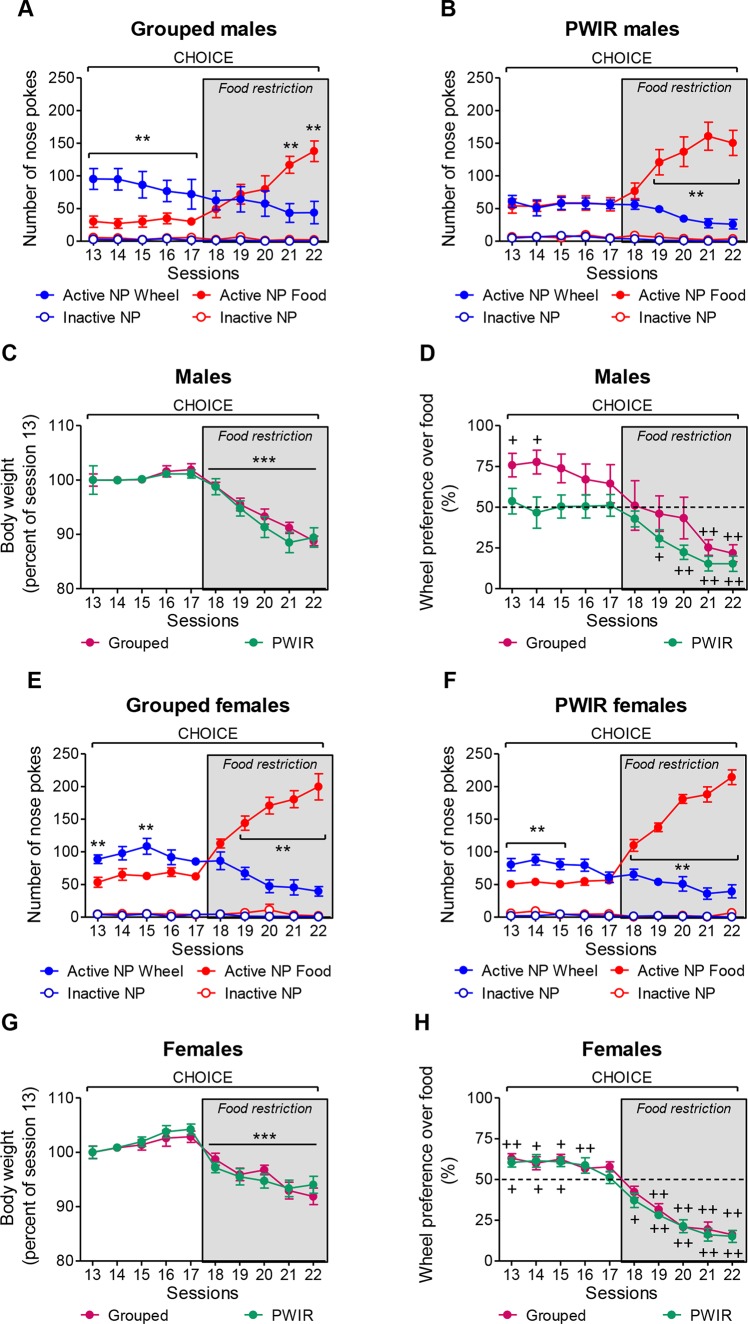
Sex-dependent effects of post-weaning isolation rearing (PWIR) on the preference between running and palatable feeding (choice sessions). (A) The difference in nose poke responses for running over feeding in grouped males was progressively inversed with food restriction. (B) Fed PWIR males displayed equal numbers of nose responses for running and feeding. (C) Grouped and PWIR male mice showed similar body weight losses during food restriction. (D) Grouped, but not PWIR, mice displayed time-dependent preferences for wheel-running over feeding. (E,F) The difference in nose poke responses for running over feeding in grouped and PWIR females was progressively inversed with food restriction. (G) Identical body weight losses in food-restricted grouped and PWIR female mice during the choice sessions. (H) Similar profiles of wheel-running preference over feeding in grouped and PWIR females during the choice sessions. The values are the mean ± standard error of the mean of n = 5–6 mice. ** p < 0.01 for the time-dependent differences between nose poke responses for wheel-running and feeding ( post hoc Tukey tests following significant session x reward interaction in the multiple-way analyses of variance), and *** p < 0.001 for the overall impacts of food restriction on body weights (multiple-way analyses of variance). +
p < 0.05 and ++
p < 0.01 for the differences with the non-preference (50%) level (one-tailed Student t-tests).